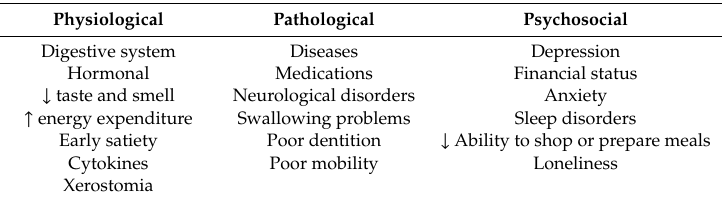
Table 1. Major changes occurring with